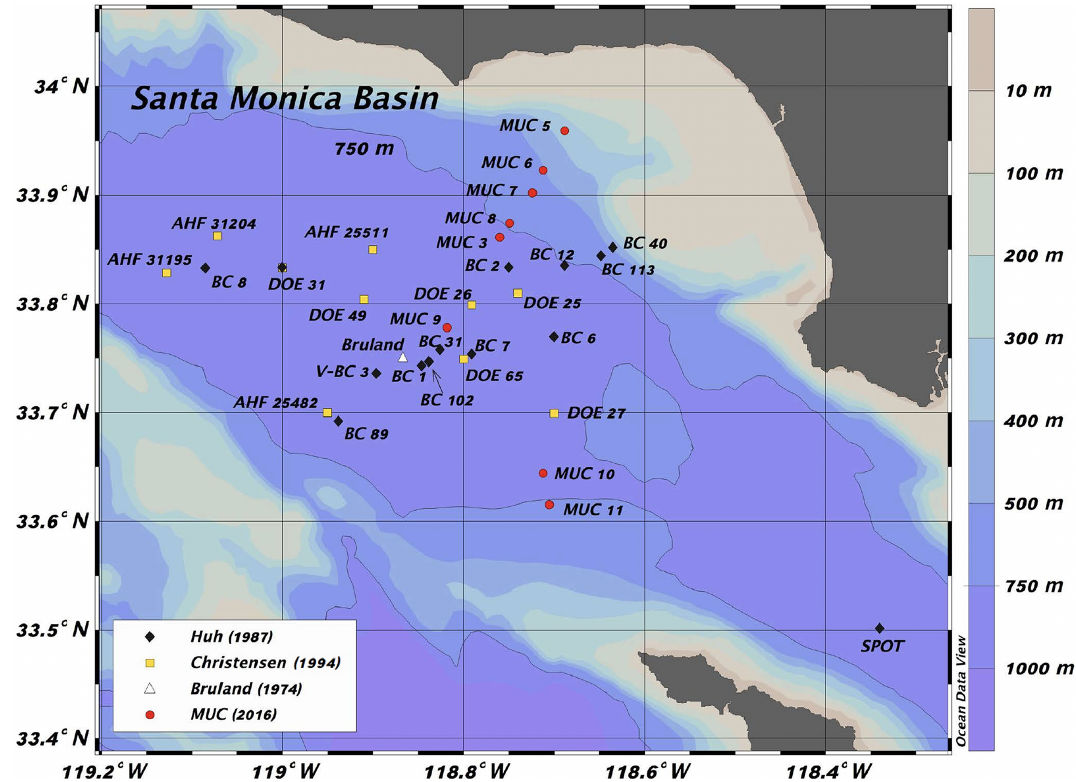
Figure 1. Core locations and IDs as documented by the authors cited in the legend. MUC represents multicores analyzed by our